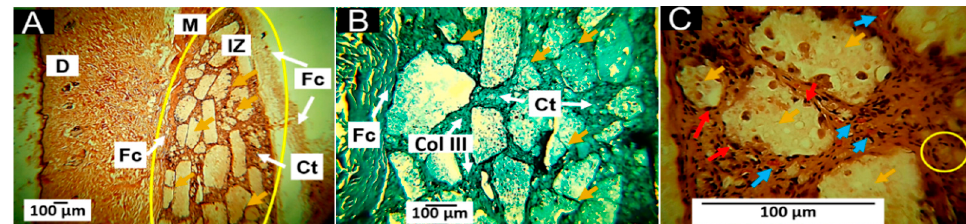
Figure 14. Subdermal implants of F4 (12%PCL/70%PLA/5%Gly/3%ZnO-NPs/10%TTEO) at 60 days. ( A ): Formulation F4 at 4× HE technique. ( B ): Formulation F4 at 10× GT technique. ( C ): Formulation F4 at 40× HE technique. Yellow oval: Implantation zone. D: Dermis. M: Muscle. Fc: fibrous capsule. Ct: connective tissue. IZ: Implantation zone. Col III: type III collagen. Yellow arrows: Fragments of material F3. Red arrows: Inflammatory cells. Blue arrows: Blood vessels. Yellow circle: Inflammatory cells surrounding a small fragment.